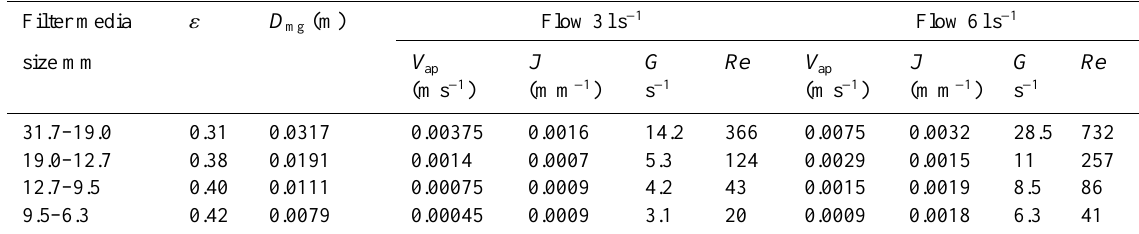
Figure 2. CF-UGF Unit Scheme (2–3: monitoring points of water quality). Table 2. Velocity gradients in the CF-UGF for the 2 flows of